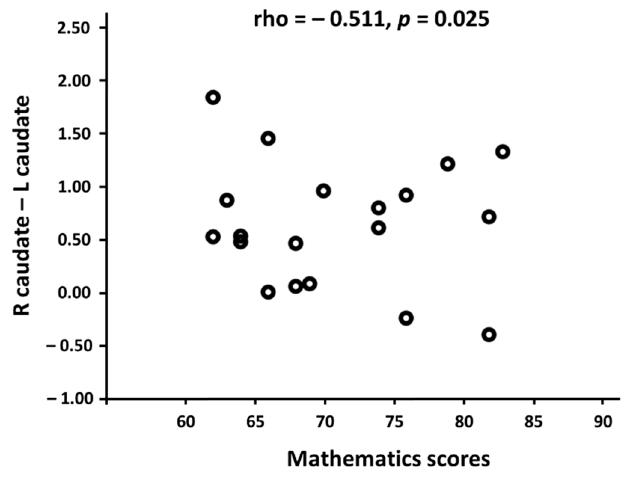
Figure 3. The relationship between the mathematics scores and the functional connectivity (normalized r values) between the bilateral caudate nucleus in the mathematicians. X -axis indicates the mathematicians’ scores in the standardized mathematics test and the Y -axis indicates the functional connectivity values between the left and right caudate nucleus using Pearson’s correlation coefficients. A significant negative correlation was found only in the mathematician group.